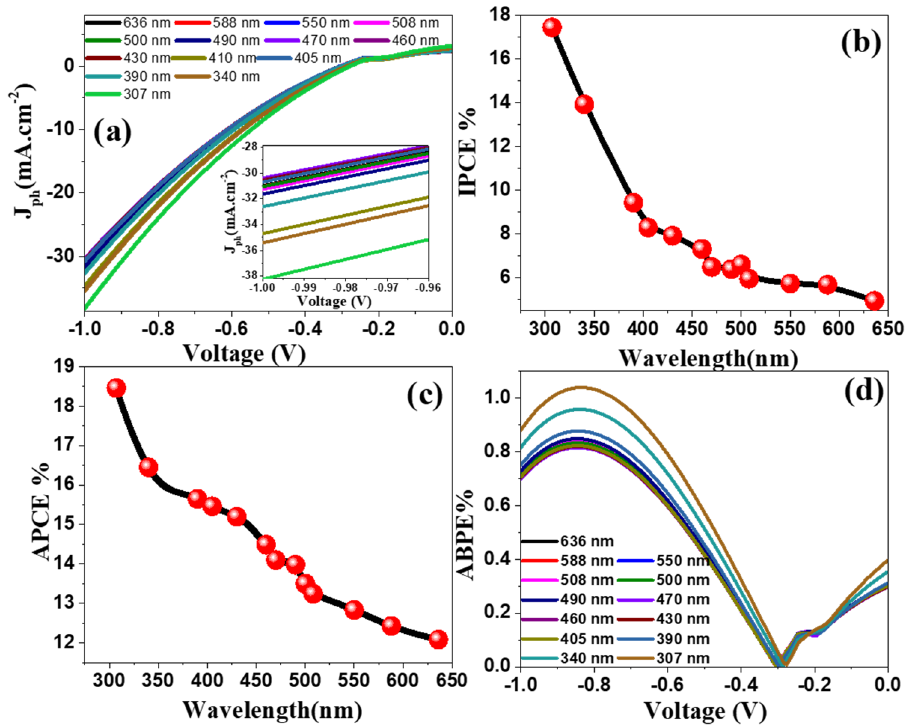
Figure 9. ( a ) J ph –voltage characteristics of 3.0% Ni-doped SnO 2 :Ir photoelectrode under monochromatic light illumination at RT in 0.5M HCl, ( b ) IPCE%, ( c ) ABCE% ( λ ) at − 1 V versus the incident λ , and ( d ) ABPE% as a function of the applied V at different λ . The inset of ( a ) shows the effect of wavelength on the J ph –voltage at high potential window.